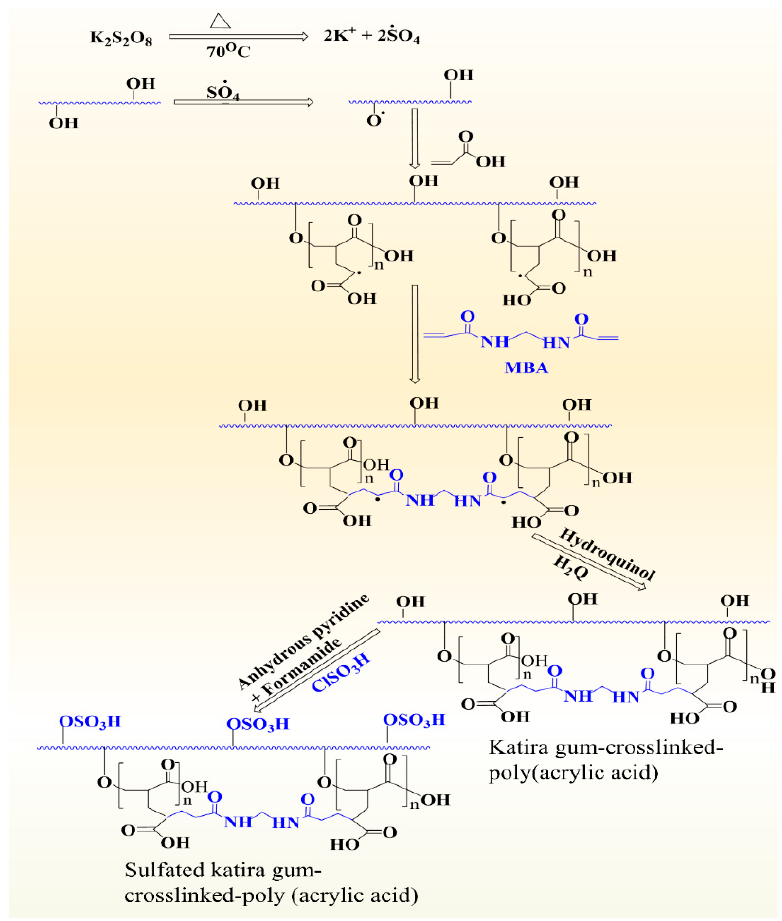
Figure 6. Sulfation of gum katira-crosslinked poly(acrylic acid) hydrogel using chlorosulfonic acid in the presence of anhydrous pyridine and formamide to produce sulfated gum katira-crosslinked poly(acrylic acid). Reprinted/adapted with permission from [15].